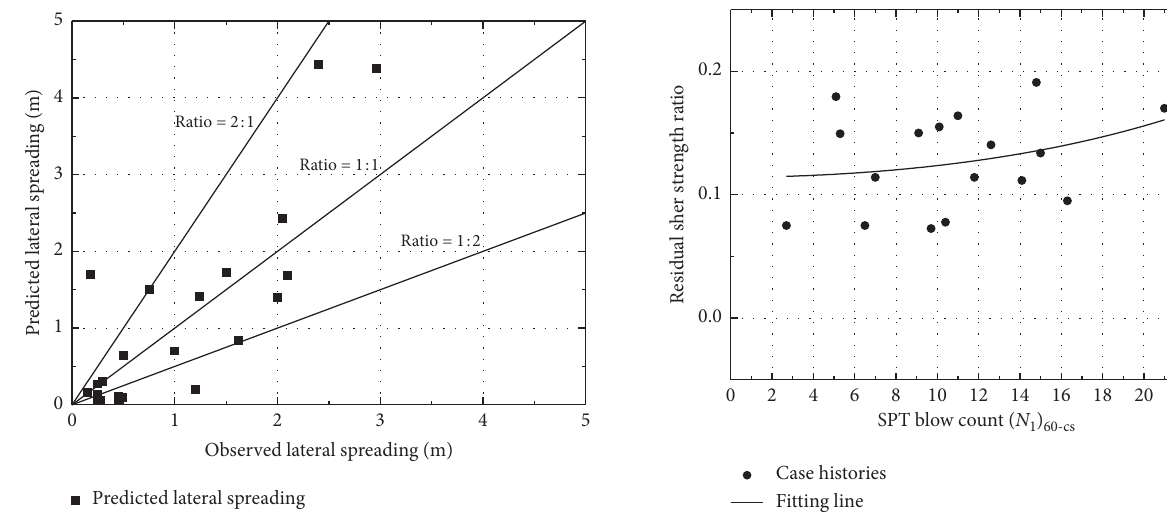
Figure 6. The average value of the residual shear strength ratios is used for the condition that one equivalent clean sand corrected SPT blow count of the liquefied soil is corresponding to various ratios. An exponential function is used to correlate the residual shear strength ratio to equivalent clean sand corrected SPT blow count of liquefied soil. In equation (8), the exponential function used for fitting is shown: